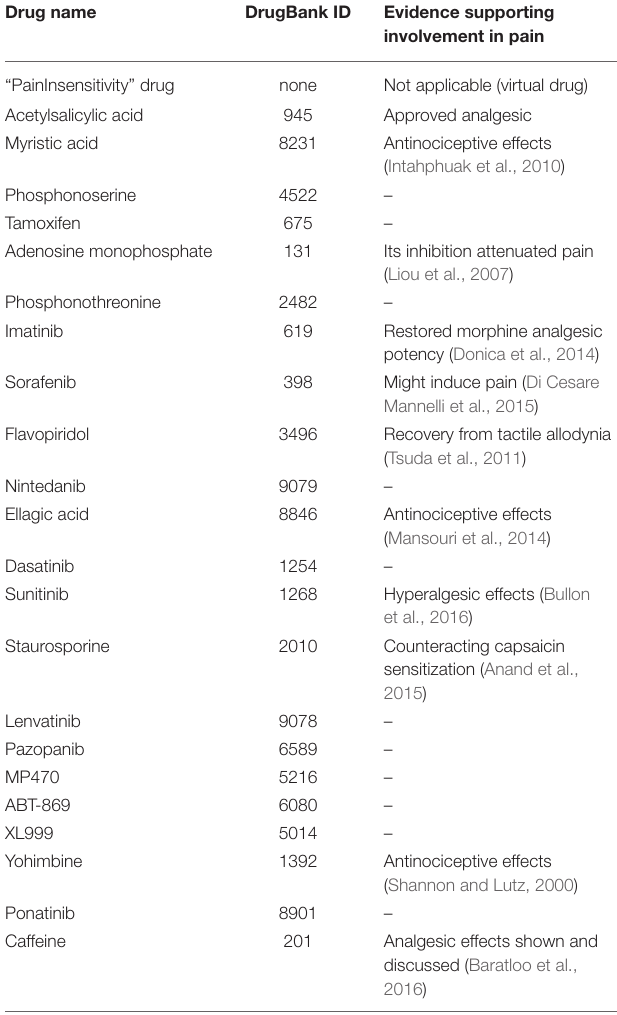
TABLE 5 | Candidate DrugBank listed substances that qualify for repurposing as treatments of pain, according to the similarity between the biological processes associated with the n = 20 genes causally involved in human insensitivity to pain and captured in the virtual “PainInsensitivity” drug, and the biological processes in which the 413 drugs queried from the DrugBank database (Wishart et al., 2006, 2008) are